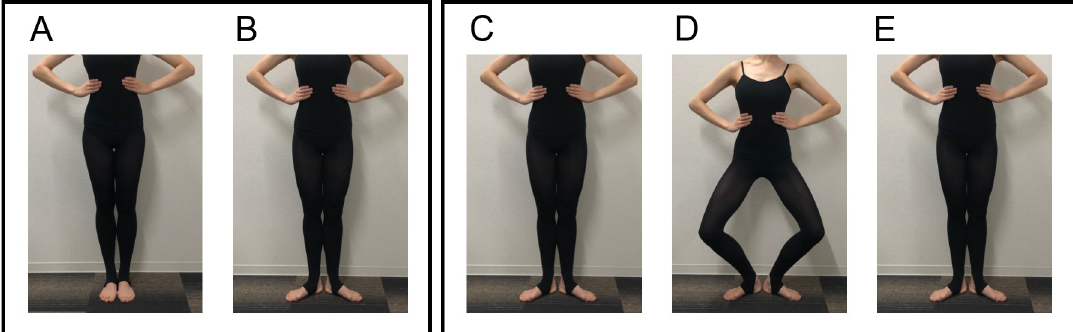
Fig 1. Experimental task for the (A, B) standing and (C, D, E) plie´ conditions. For the standing condition, participants were first instructed to stand in the sixth position (A), to change to the first position (B), and to maintain the position for a few seconds. For the plie´ condition, they were instructed to stand in the first position (C), to flex the knees for 1 s, to stay in the position for 1 s (D), and to extend the knees for 1 s to the first standing position (E) according to 1 Hz metronome beat. Durations for kinematic analysis were the time of (B) for standing condition and that of (D) for plie´ condition (please see Data analysis for criteria in